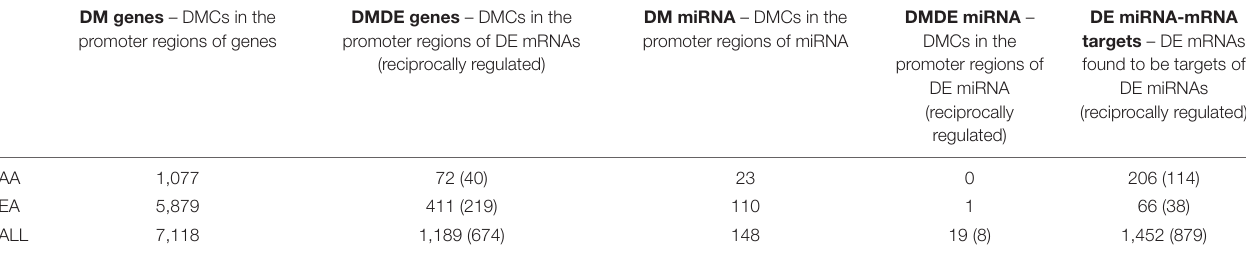
TABLE 3 | Significant pairs identified by integrative analysis of DNA methylation, miRNA expression, and mRNA expression. DM genes – DMCs in the promoter regions of genes